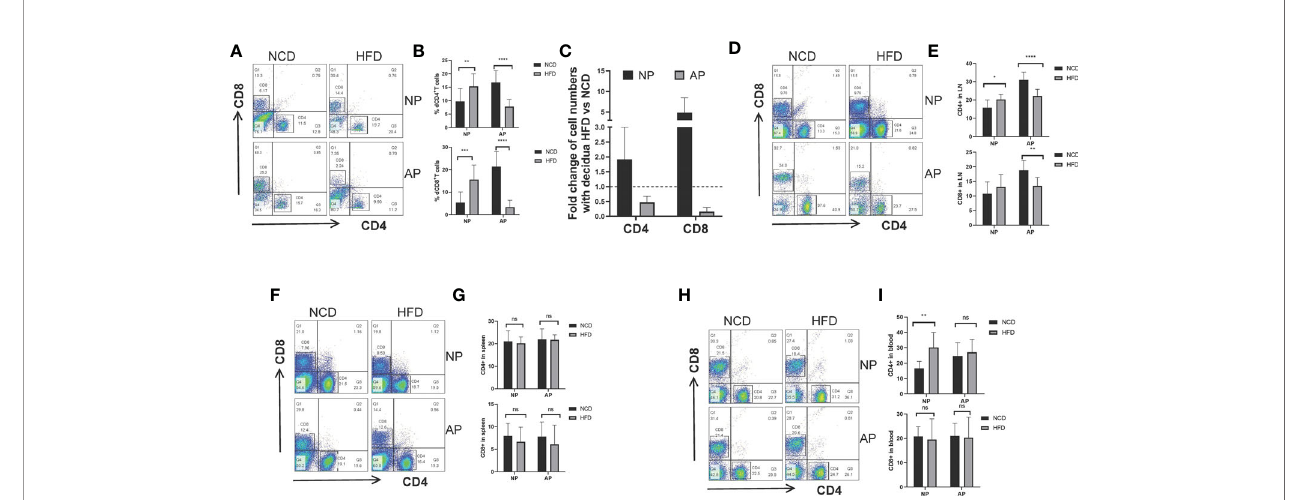
FIGURE 4 | Maternal obesity mediates opposite effects on CD4 + and CD8 + T lymphocytes in NP and AP models. (A, B) Representative and quantitative fl ow cytometry results for CD4 + and CD8 + T cells in deciduas derived from NP and AP models fed with NCD or HFD. (C) Fold changes of decidual T cell numbers in NP and AP mice under obesity challenge. (D, E) Frequencies of CD4 + and CD8 + T cells in lymph nodes. (F, G) Frequencies of CD4 + and CD8 + T cells in spleens. (H, I) Frequencies of CD4 + and CD8 + T cells in blood. Data are presented as mean ± SEM. NS, not signi fi cant; *p < 0.05, **p < 0.01, ***p < 0.001, ****p < 0.0001.